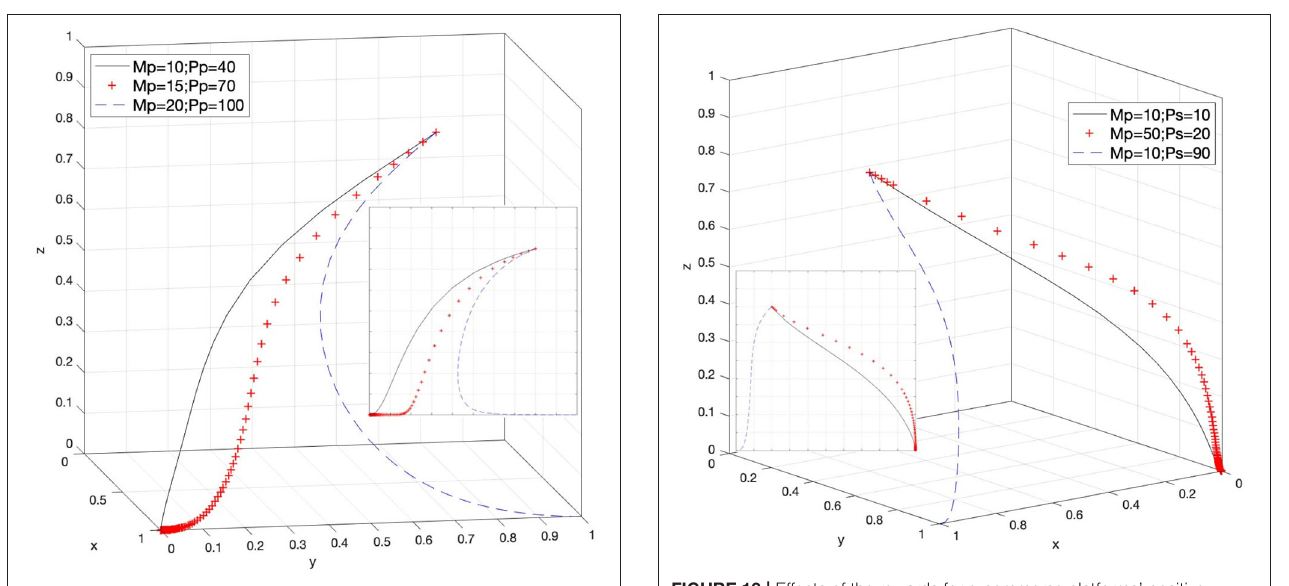
FIGURE 11 | Effect of rewards and punishments for different positive attitudes toward e-commerce platforms under strict government supervision.